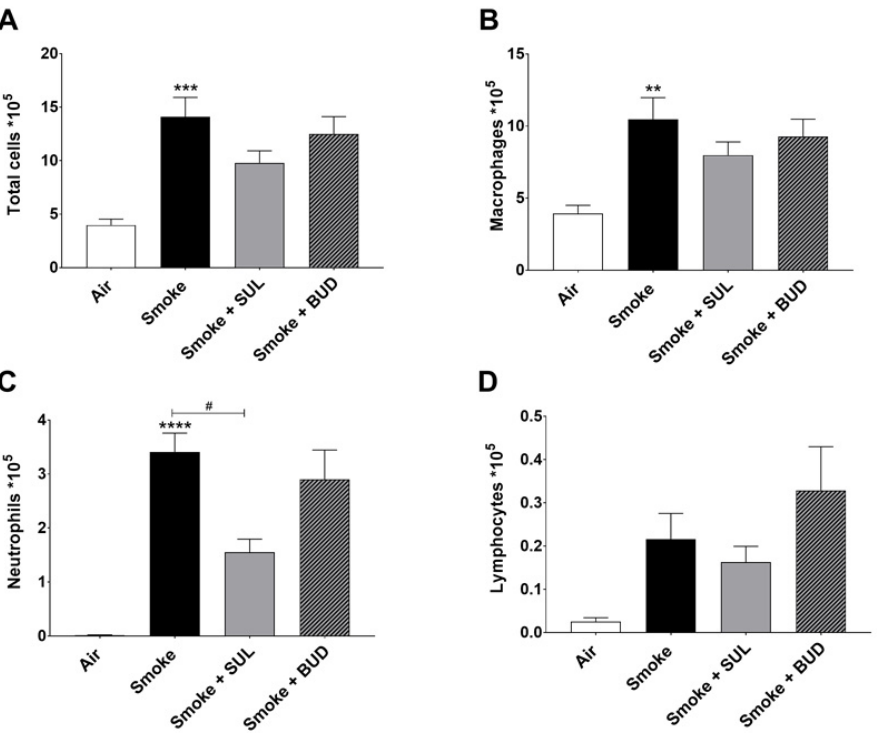
Figure 4. SUL-151 reduces the influx of neutrophils in the BALF after the development of CS-induced pulmonary inflammation. Mice were exposed to CS for 10 days (twice/day) and received SUL-151 or budesonide via oropharyngeal administration (once/day) 30 min before the first-time smoke exposure during the last 5 days of the CS exposure period. On day 11, lungs were lavaged, and BALF was collected for total ( A ) and differential BAL cell counts, including macrophages ( B ), neutrophils ( C ), and lymphocytes ( D ). Values are expressed as mean ± SEM. ** p < 0.01, *** p < 0.001, **** p < 0.0001, smoke group compared to air group; # p < 0.05, smoke + SUL group or smoke + budesonide (BUD) group compared to smoke group. n = 6–7 mice/group.